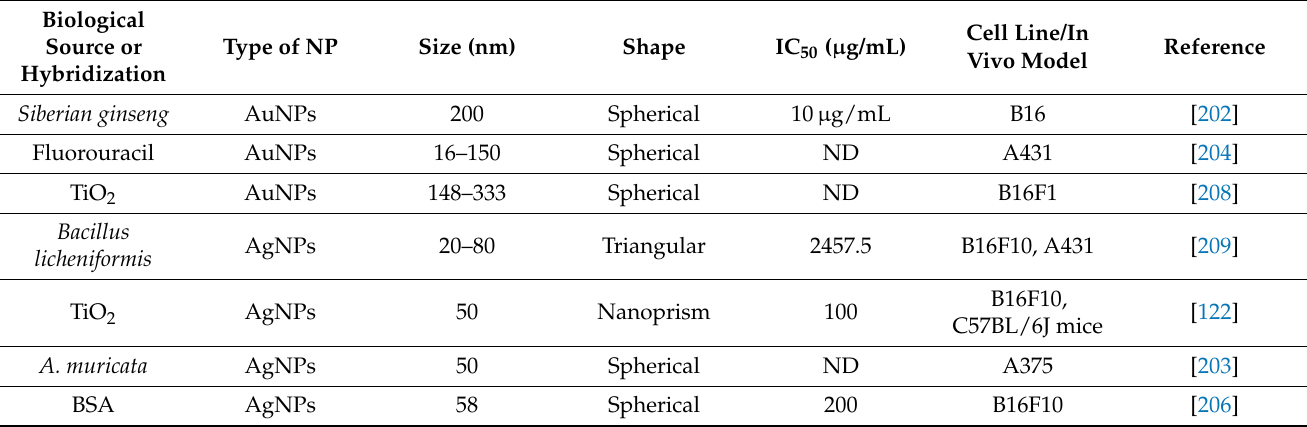
Table 5. Evaluation of green biogenic Au and AgNPs in skin cancer cells; biological source, NPs characteristics, IC 50 , and cell